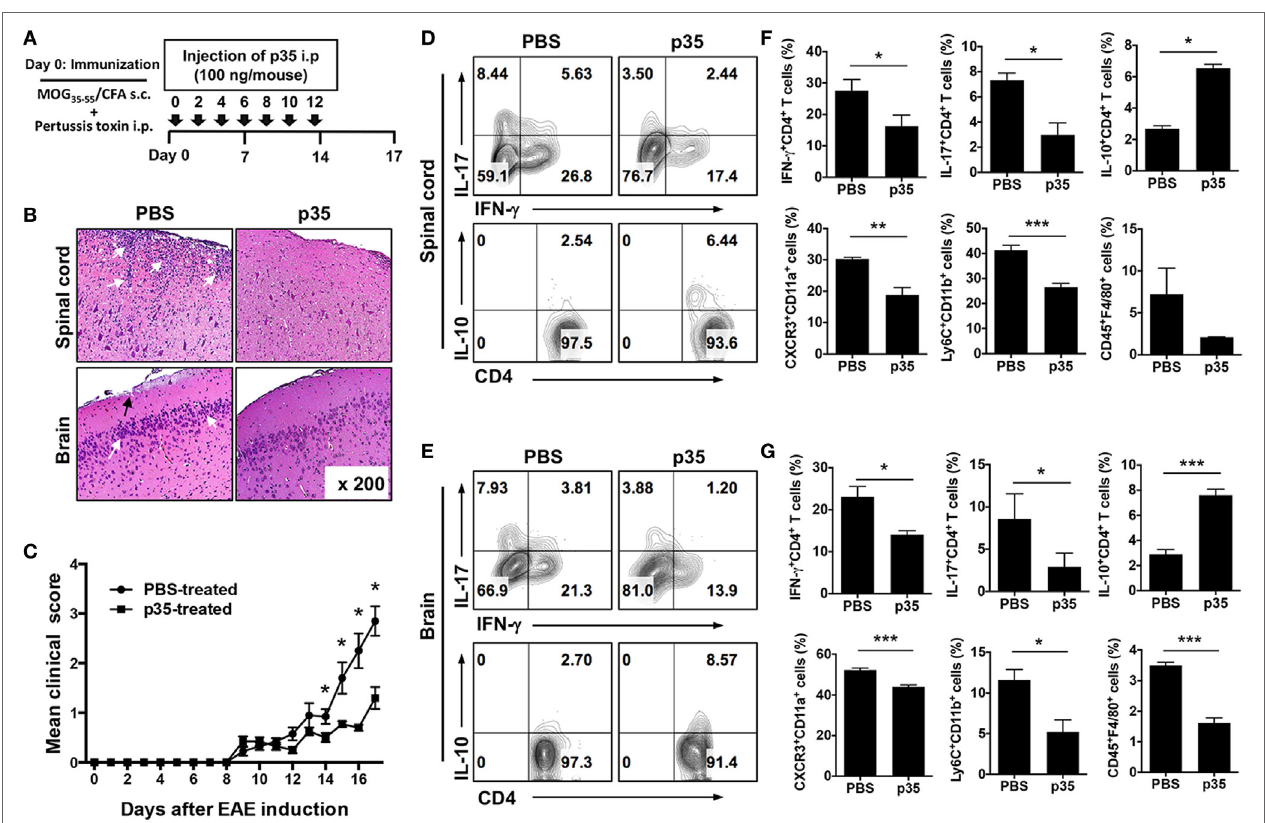
FigUre 1 | IL-12p35 reduced the severity of experimental autoimmune encephalomyelitis (EAE) induced by active immunization with MOG 35–55 . (a) Schematic showing the treatment strategy. EAE was induced by immunization of C57BL/6J mice treated with MOG 35–55 -peptide in complete Freund’s adjuvant (CFA) ( n = 12). Mice were treated by intraperitoneal injection of IL-12p35 (100 ng/mouse) or PBS on day 0 of immunization and every other day until day 12 post-immunization. (B) Representative photomicrographs of H&E stained sections of spinal cord and brain of mice on day 17 post-immunization (original magnification 200 × ). White arrows show inflammatory cells in the spinal cord or brain; black arrows denote inflammatory lesions in brain subpial location. (c) EAE clinical scores. (D–g) Characterization of immune responses on IL-12p35-treated EAE mice. Both spinal cord and brain cells were collected from individual mice, and the isolated cells were analyzed using FACS. The data are presented as the mean ± SEM of three determinations. **** p < 0.0001; *** p < 0.001; ** p < 0.01; * p < 0.05, significantly different from PBS-treated